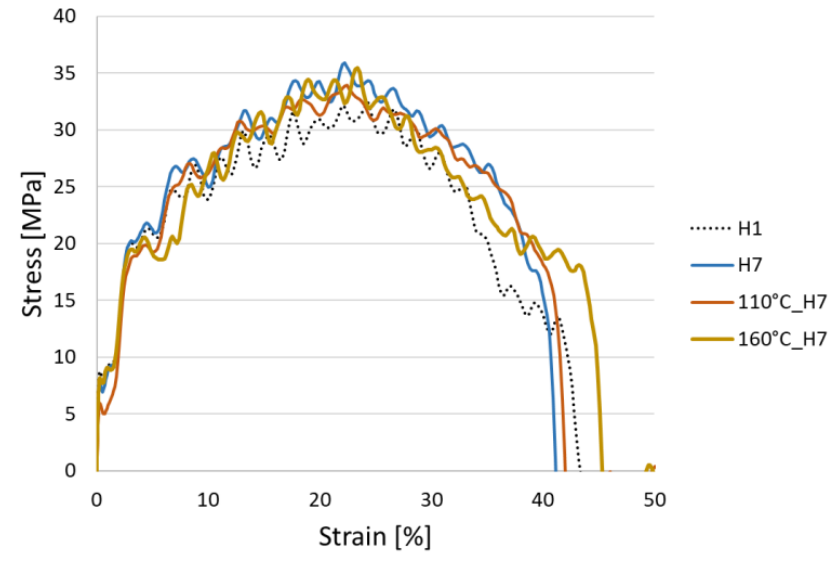
Figure 5. Stress–strain curves. Figure 5. Stress – strain curves. Table 3. Evaluated data from the dynamic tensile test with recorded surface temperature differences.